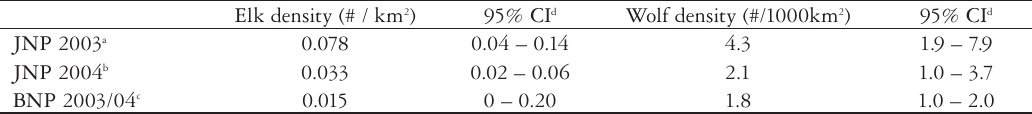
Table 2. Threshold elk and wolf densities above which caribou populations decline (i.e., λ <1) at kill-rate values (see subscripts) that caused mortality to exceed recruitment for the southern Jasper National Park and Banff National Park caribou populations. Differences in Jasper thresholds between years were a result of higher calf recruitment in 2003. See eq. 3 and text for how thresholds were calculated. Elk density (# / km 2 )